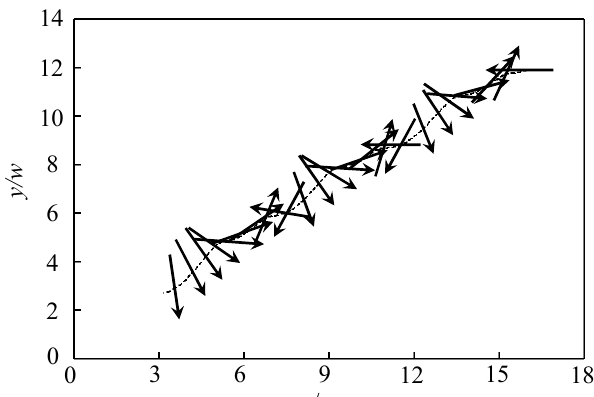
Fig. 23 Locus of a falling plate ( λ = 0.3, AR = 10, I * = 0.75, Re ( V ) = 1.63 × 10 4 , Re = 7.1 × 10 3 – 7.7 × 10 3 )). Arrows and a dotted line denote the cross-section direction of a plate and the trajectory of a plate’s centre,